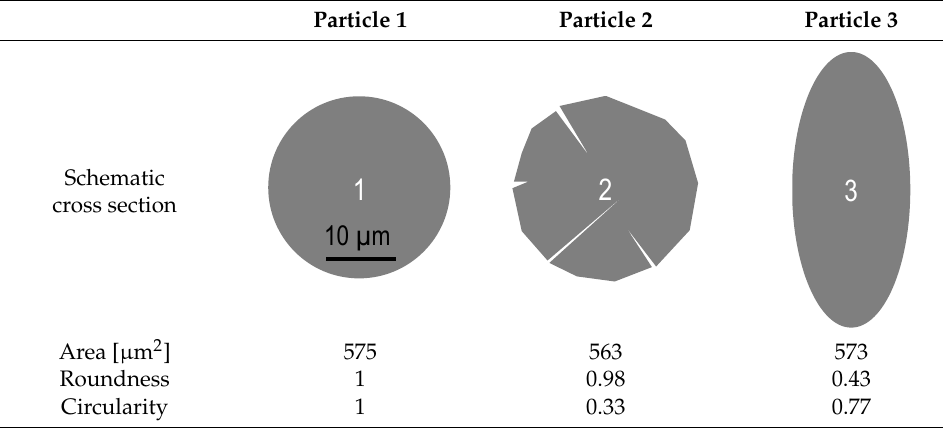
Table 4. Difference between roundness and circularity for various particle shapes.